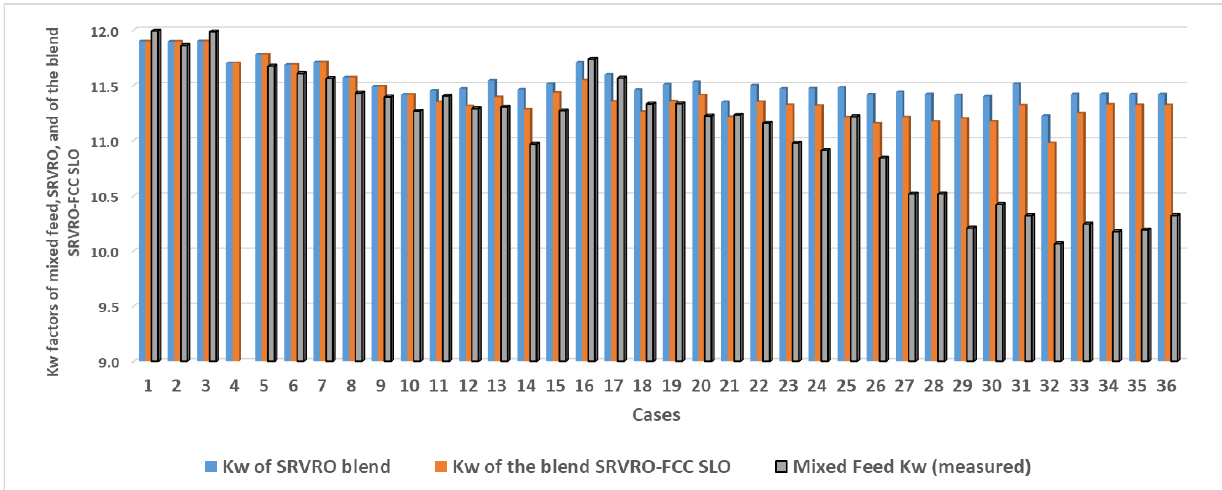
Figure 3. Kw for the blended SRVROs, the mixture SRVRO-FCC SLO, and for the mixed